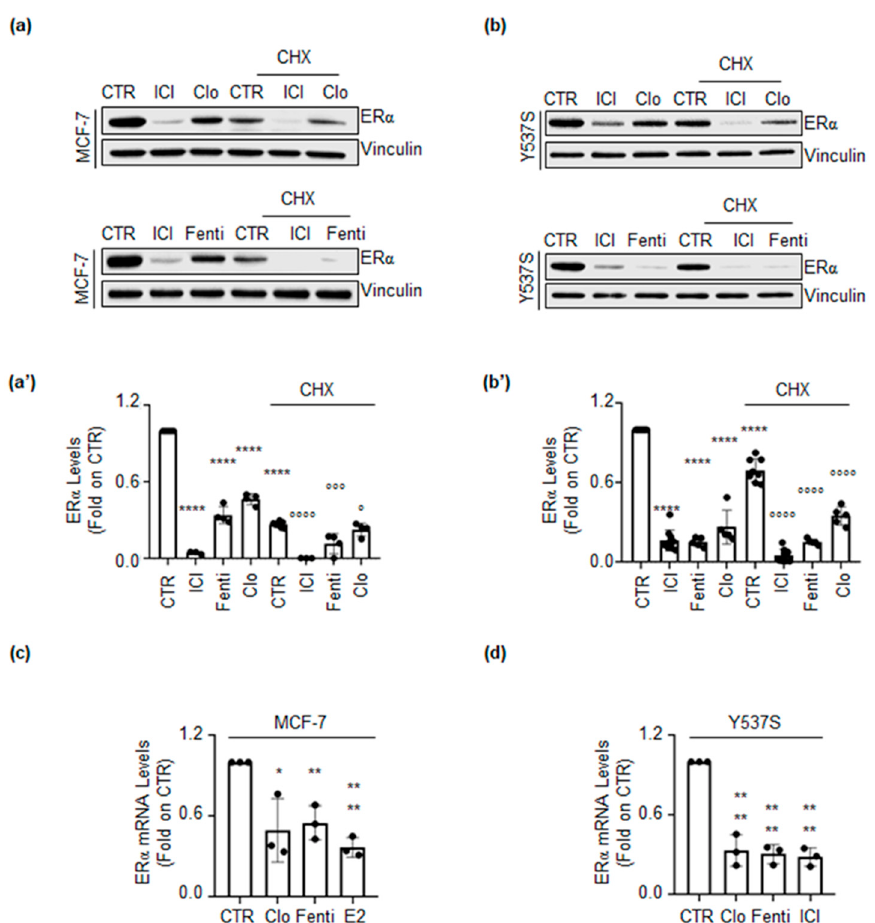
Figure 4. Transcriptional and post-transcriptional regulation of ER α levels by clotrimazole and fenticonazole. Western blotting and relative densitometric analysis of ER α levels in MCF-7 ( a ) and ( a’ ) or in Y537S ( b ) and ( b’ ) cells pre-treated with cycloheximide (CHX 1 µ g/mL for MCF-7 cells and 0.1 µ g/mL for Y537S cells) for 6 h and then treated with fulvestrant (ICI 100nM), clotrimazole (Clo 10 µ M) and fenticonazole (Fenti 10 µ M) for 72 h. The loading control was done by evaluating vinculin expression in the same filter. Panels show representative blots of three independent experiments. Significant differences with respect to the CTR sample are calculated by Student t-test and indicated by **** ( p -value < 0.0001). Significant differences with respect to CHX sample are calculated by Student t-test and indicated by ( ◦ p -value < 0.05), ◦◦◦ ( p -value < 0.001) and ◦◦◦◦ ( p -value < 0.0001). ( c ) RT-qPCR analysis of ER α mRNA levels in MCF-7 (c) and Y537S ( d ) cells treated with Clo or Fenti (10 µ M) or E2 (1 nM) and ICI (1 µ M) for 72 h. ER α mRNA expression was normalized to the GAPDH mRNA expression. The experiments were performed in triplicate. Significant differences with respect to CTR sample are calculated by Student t-test and indicated by * ( p -value < 0.05), ** ( p -value < 0.01) and **** ( p -value <